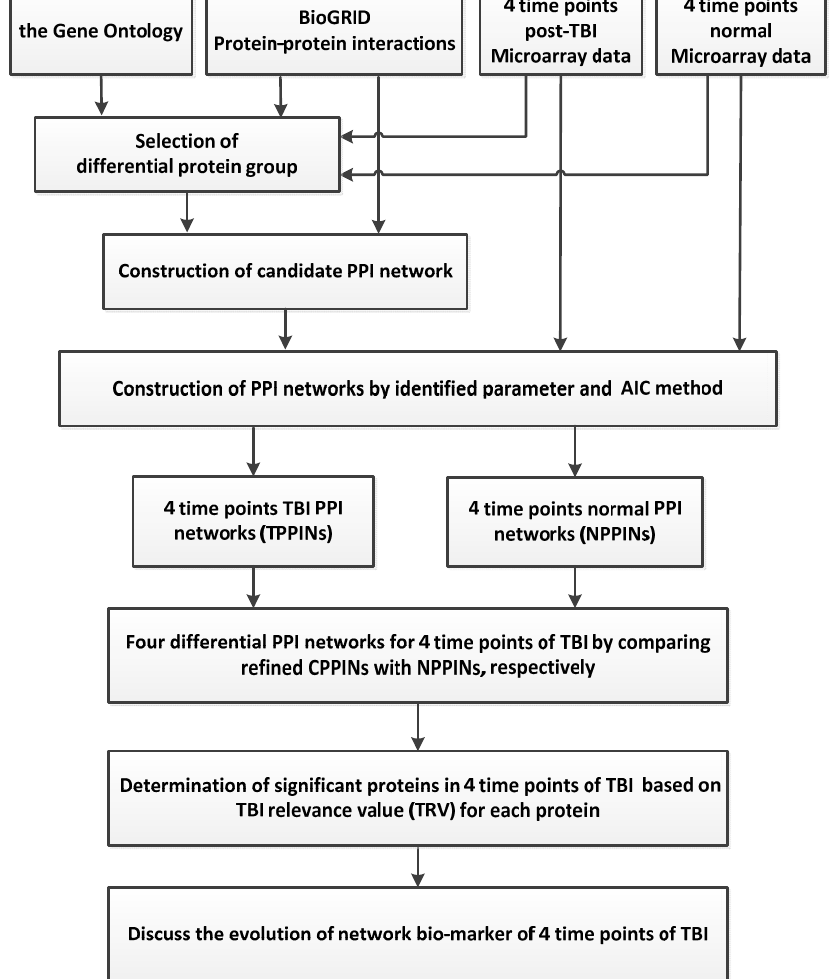
Figure 7. The method by which we constructed the network markers for four time points with respect to TBI and investigated the underlying molecular mechanisms of TBI. BioGRID: Biological General Repository for Interaction Database.